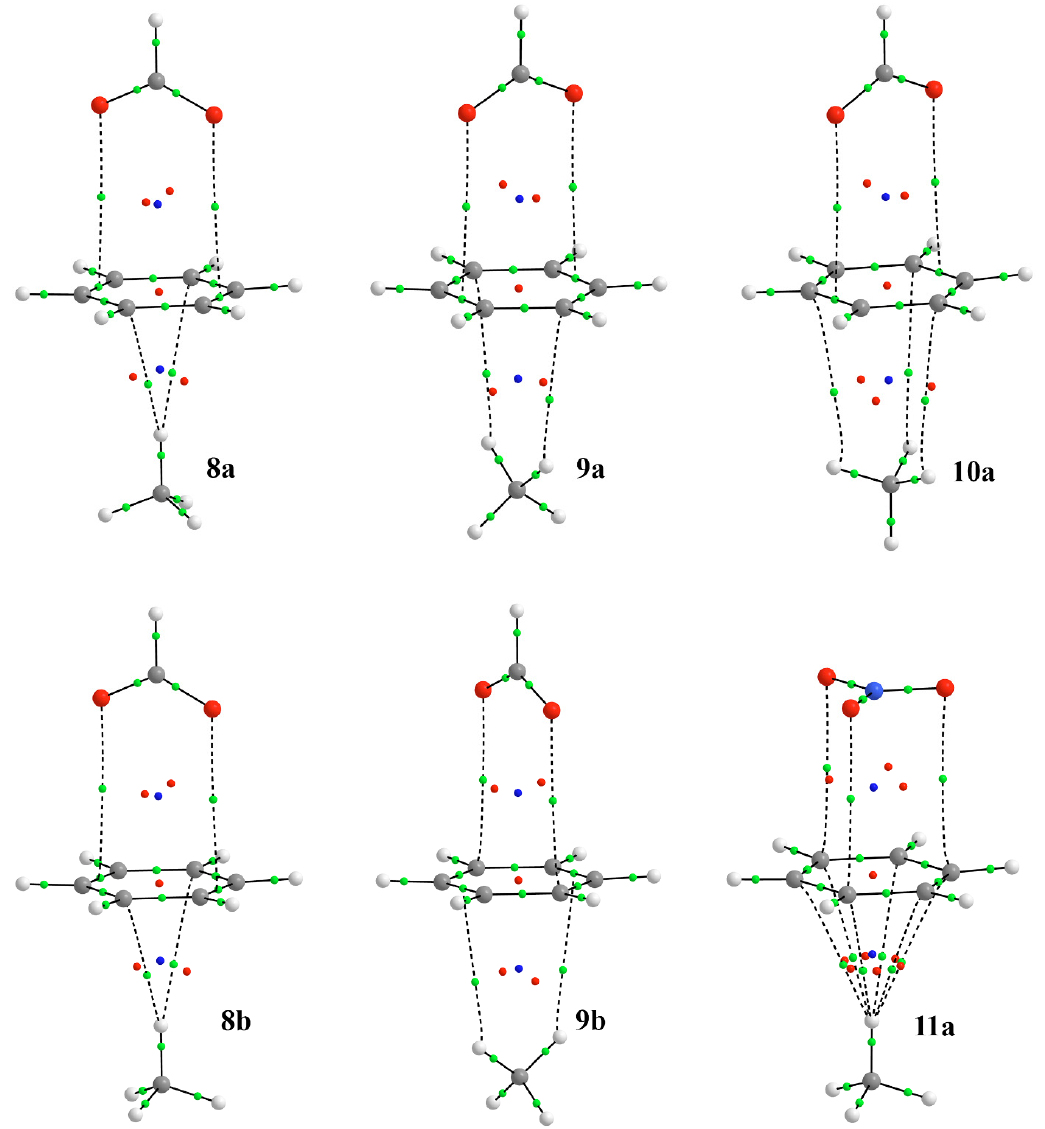
Figure 6. Molecular graphs of a selection of three-component complexes 8a , 9a , 10a , 8b , 9b , 11a . The BCPs, ring and cage critical points are represented by green, red, and blue dots, respectively. Only bond paths are depicted (intermolecular bond paths are shown as dashed lines). Carbon, nitrogen, oxygen, and hydrogen atoms are indicated in grey, blue, red, and white color, respectively.